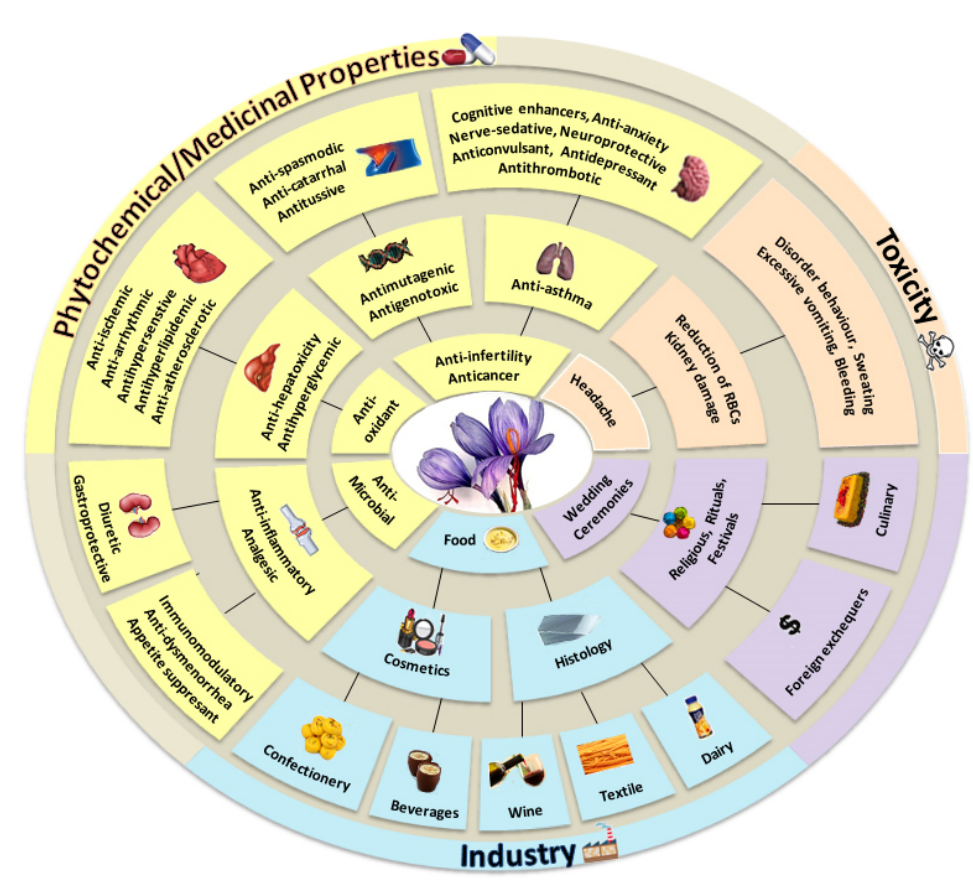
Figure 1. Potential uses of